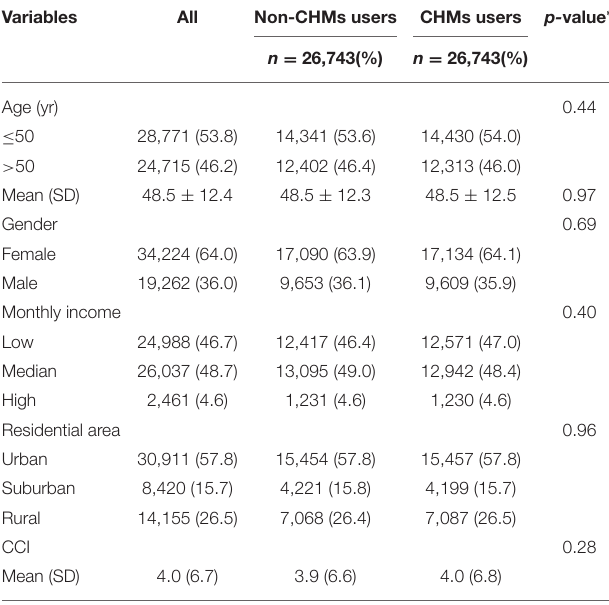
TABLE 1 | Demographic data and selected comorbidities of the study subjects.